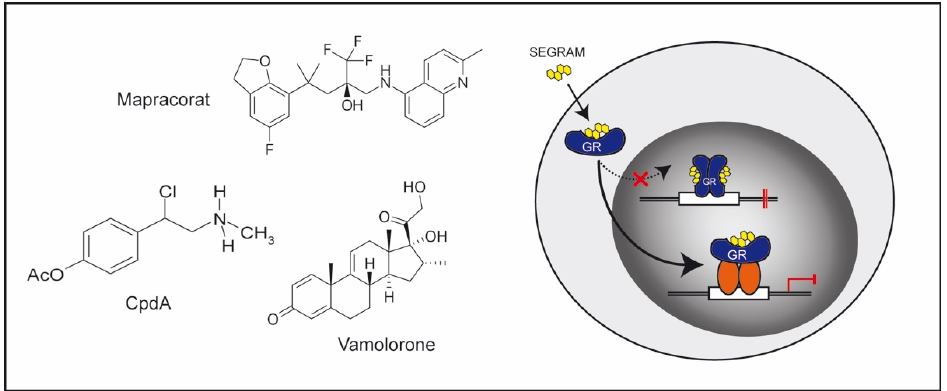
Figure 3. GC derivatives acting as SEGRAMs. Steroidal and non-steroidal compounds such as Mapracorat, Vamolorone, and CpdA have been developed that bind to the GR but still dissociate its molecular mechanisms based on their impaired ability to induce GR dimerization and DNA-binding. Hereby, gene transactivation and transrepression are altered, resulting in a different gene expression profile associated with an improved therapeutic index.